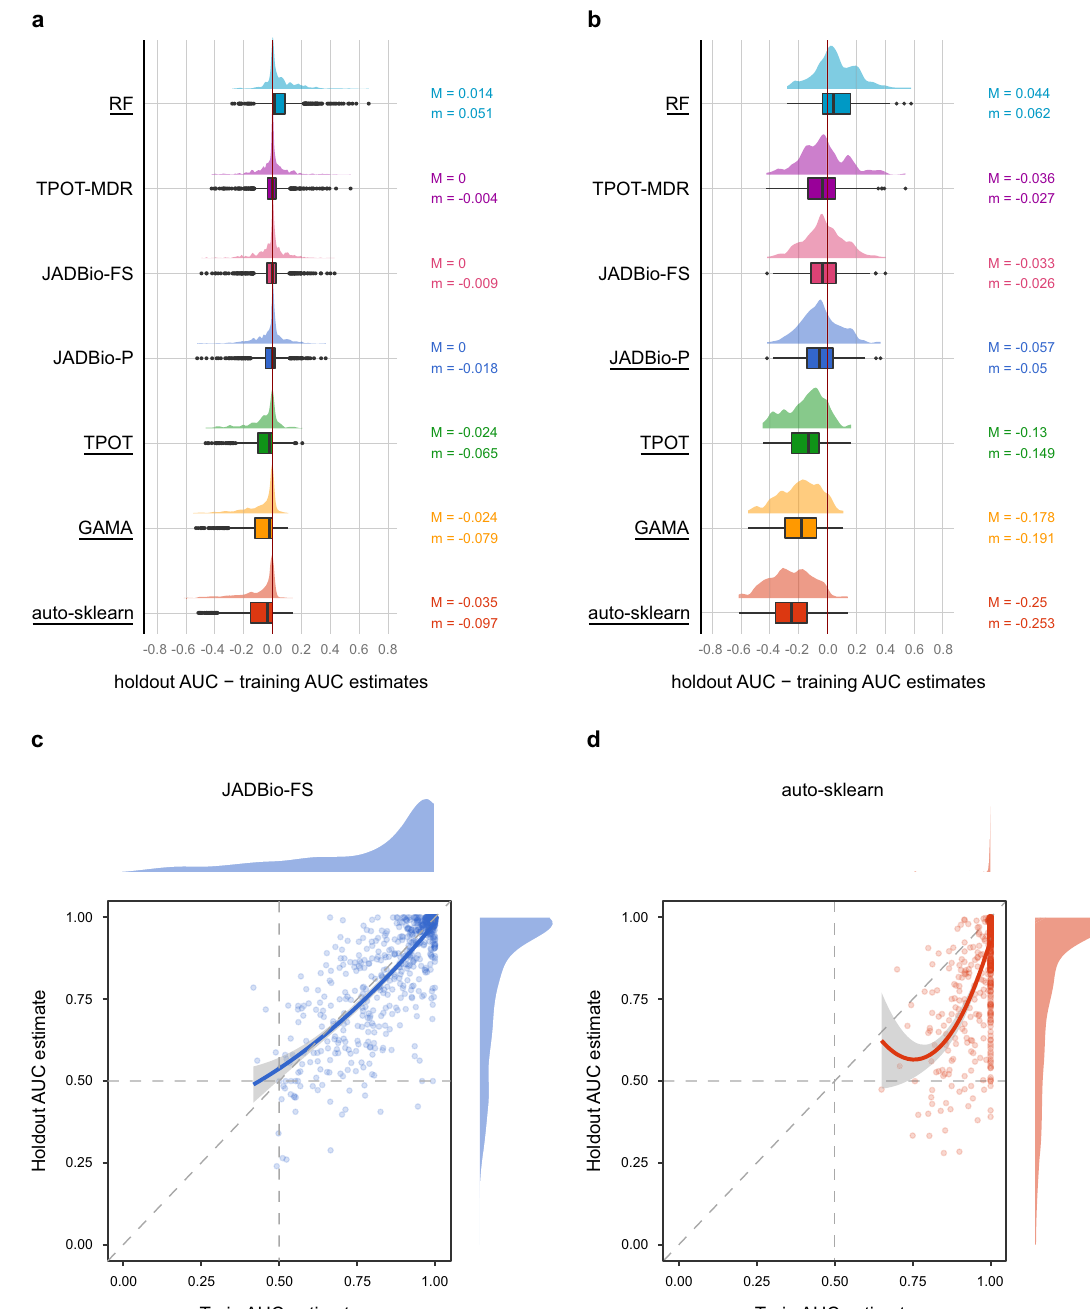
Fig. 5 Results of the quantitative comparison in terms of bias. Bias is de fi ned as the holdout AUC estimate minus the AUC estimated on the training set; distributions on the right of the zero line correspond to conservative estimates, while results on the left of the line are optimistic. a AUC bias distribution across 720 classi fi cation tasks (2 tasks for each of the 360 datasets). The distribution for each tool is reported both as a box and violin plot. Tools with median bias statistically signi fi cantly different from zero have their name underscored. Median (M) and average (m) bias values are reported on the right of each boxplot axis. b Same as a , but only for the 196 runs where Random Forest (RF) achieves less than 0.8 AUC on the holdout set. On these more dif fi cult tasks, TPOT, GAMA, and auto sklearn systematically overestimate performance between 14 and 25 AUC points. c and d Scatterplots reporting the AUC estimated on the training set ( x -axis) vs. the AUC estimated on the holdout set ( y -axis) for the JADBio-FS and auto-sklearn tools, respectively. Each point corresponds to one run. Locally Weighted Scatterplot Smoothing (LOESS) regression lines indicate the main trends in the corresponding scatterplot. Auto-sklearn points and LOESS line are mostly below the diagonal, indicating systematically overoptimistic performance estimates on the training set. The bias is signi fi cantly reduced for JADBio-FS, as indicated by a LOESS regression line close to the